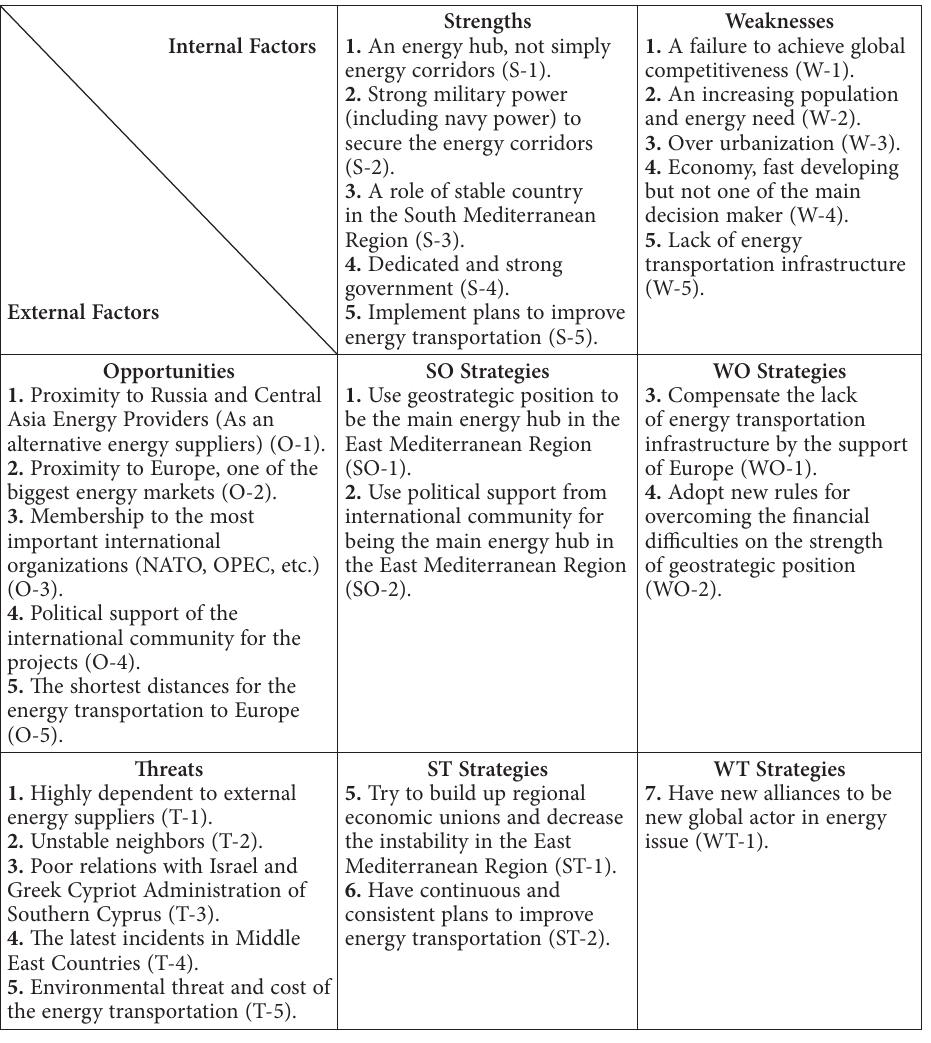
Table 6. SWOT matrix of natural gas for Turkey